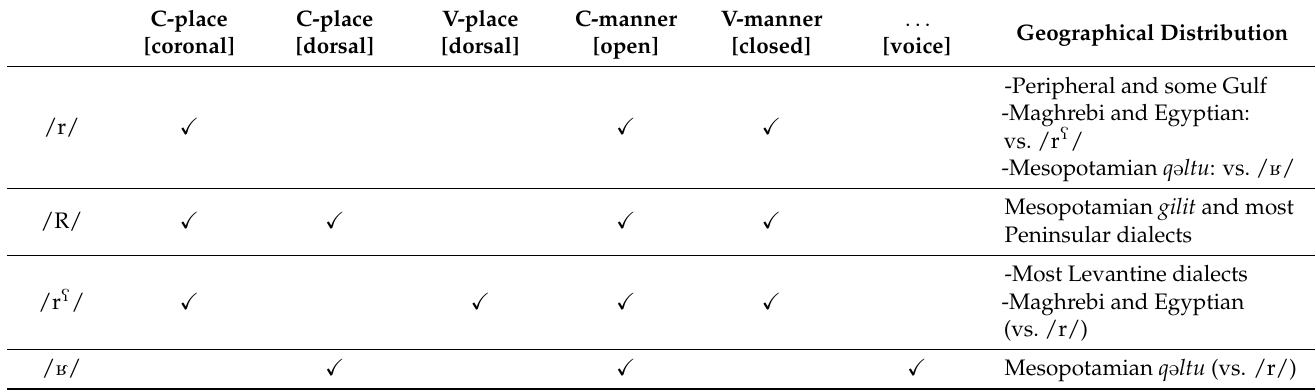
Table 6. Representational typology of * r phoneme